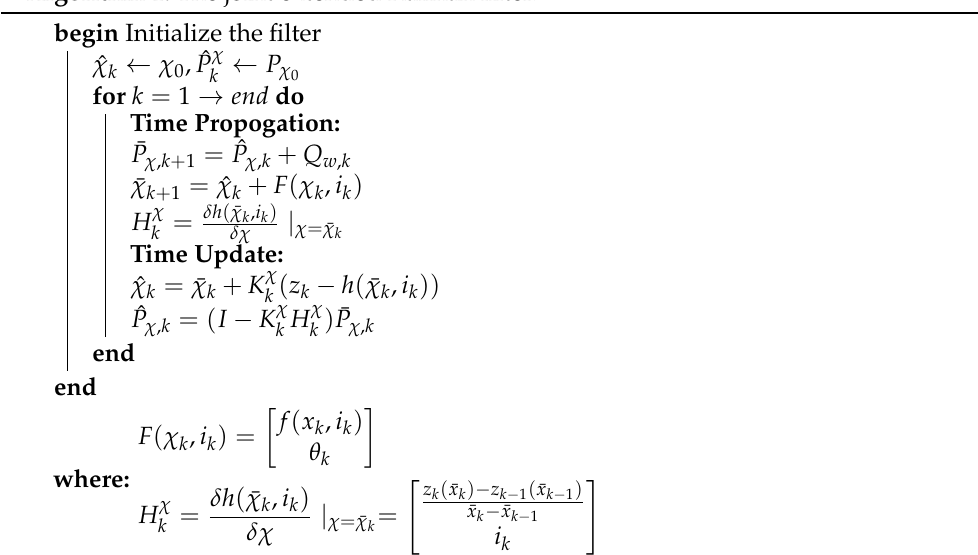
Algorithm 1: The joint extended Kalman